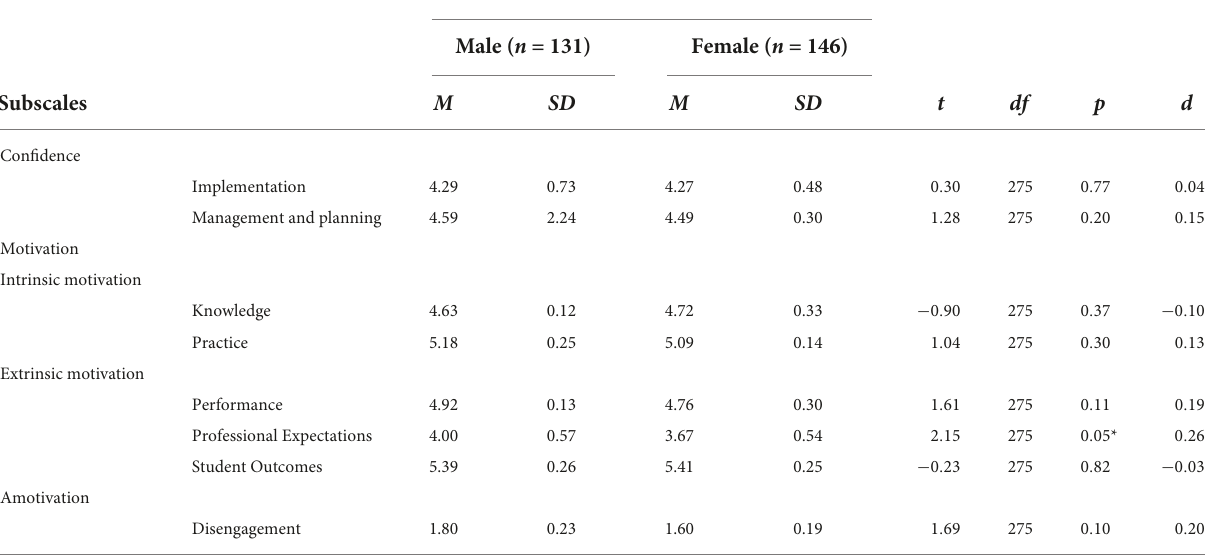
TABLE 4 Descriptive statistics and t -test results for confidence and motivation subscales by